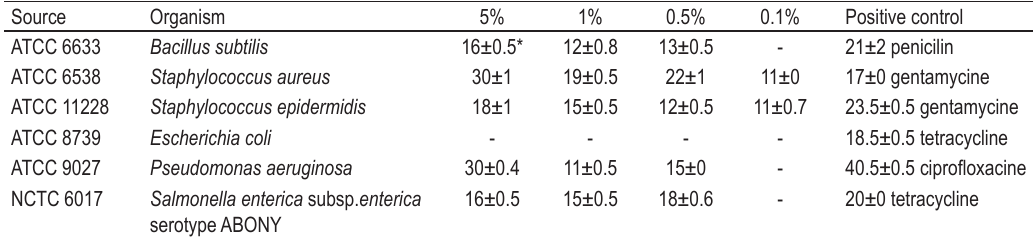
TABLE 1. Antibacterial activity (inhibition zone measured in mm, including hole 6 mm in diameter) of essential oils of L. angustifolia Source